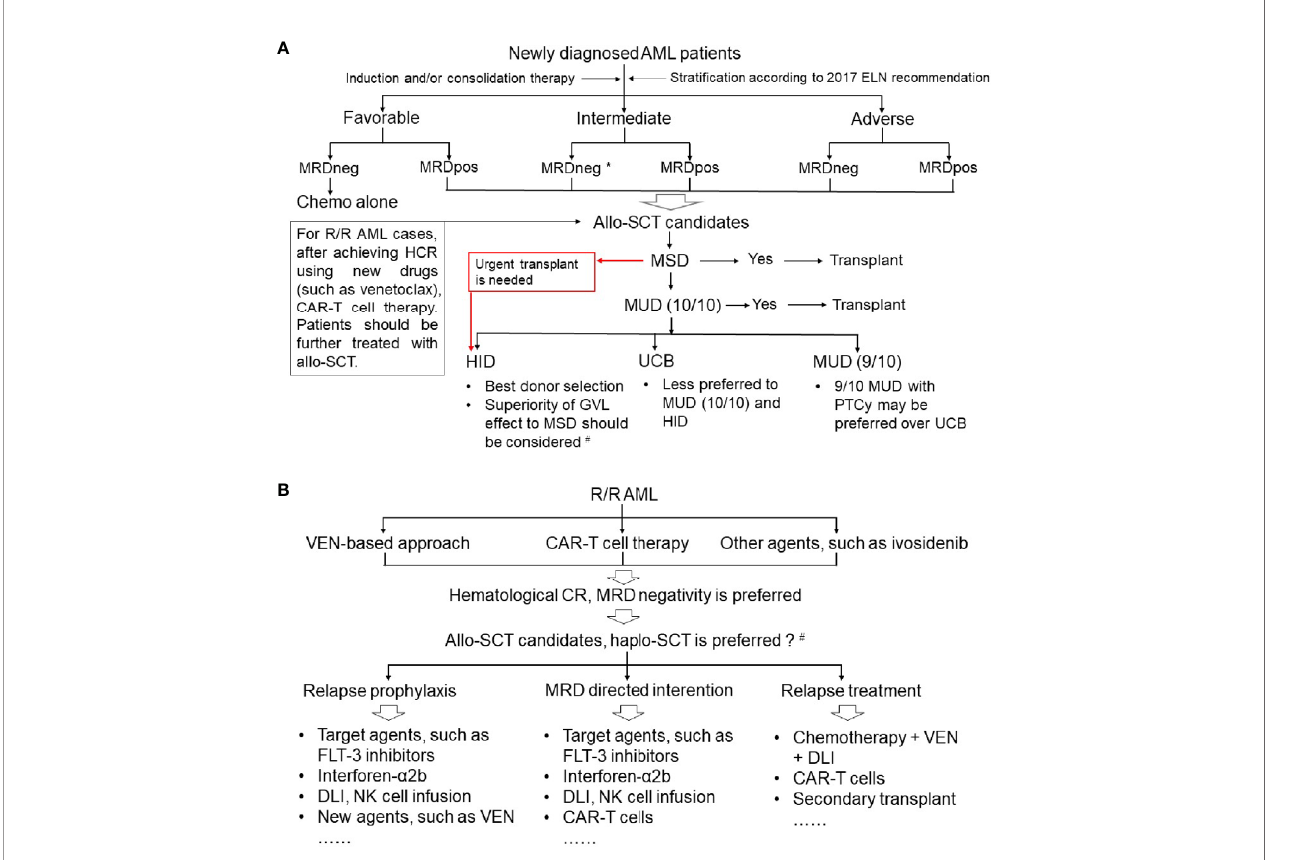
FIGURE 2 | Position of haploidentical stem cell transplantation in the treatment of acute myeloid leukemia. (A) Newly diagnosed AML; (B) refractory or relapsed AML. AML, acute myeloid leukemia; ELN, European LeukemiaNet; MRD, minimal residual disease; MRDneg, negative MRD; MRDpos, positive MRD; Allo-SCT, allogeneic stem cell transplantation; R/R, refractory or relapsed; HCR, hematological complete remission; CAR-T, chimeric antigen receptor (CAR) T cell; MSD, human leukocyte antigen (HLA)-matched sibling donor; MUD, HLA-matched unrelated donor; HID, haploidentical donor; UCB, umbilical cord blood; PTCy, post- transplant cyclophosphamide; GVL, graft-versus-leukemia; VEN, venetoclax; Haplo-SCT, haploidentical SCT; DLI, donor lymphocyte infusion; NK cell, natural killer cell. *For intermediate-risk AML patients with MRD negative CR1, controversy remains regarding the selection of chemotherapy alone, autologous SCT or allo-SCT in patients. # For pre-MRD positive AML cases, haplo-SCT had a stronger GVL effect compared with that of